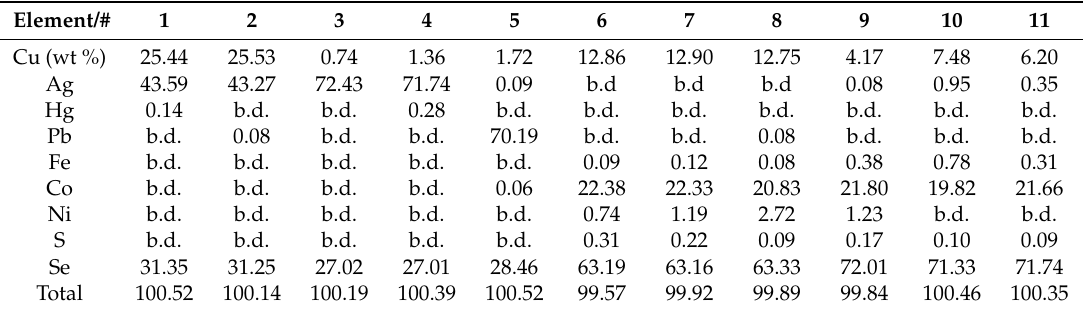
Table 3. Representative results of electron-microprobe analyses of eucairite, naumannite, clausthalite, tyrrellite, and